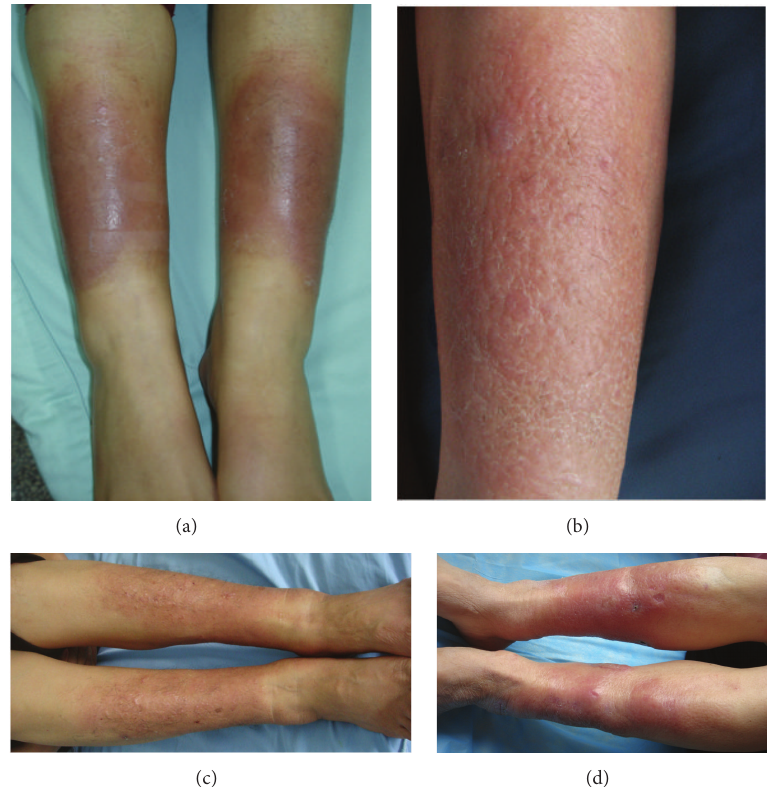
Figure 3: Diffuse swelling variant. (a) Well-circumscribed, erythematous, and nonpitting diffuse swelling (thickening when touched) of skin at the half extensors of lower legs. (b) Scaly, red, irregular circumscribed, and nonpitting diffuse swelling with orange peel-like appearance at lower two-thirds circumference of lower legs. (c) Ill-defined, erythematous, papules-and-bloody-crust scattered, and nonpitting diffuse swelling with local hypertrichosis at the lower two-thirds extensors of lower legs. (d) Scarlet, bloody crust, and nonpitting swelling of skin with atrophic scars at the lower three-fourths circumference of lower